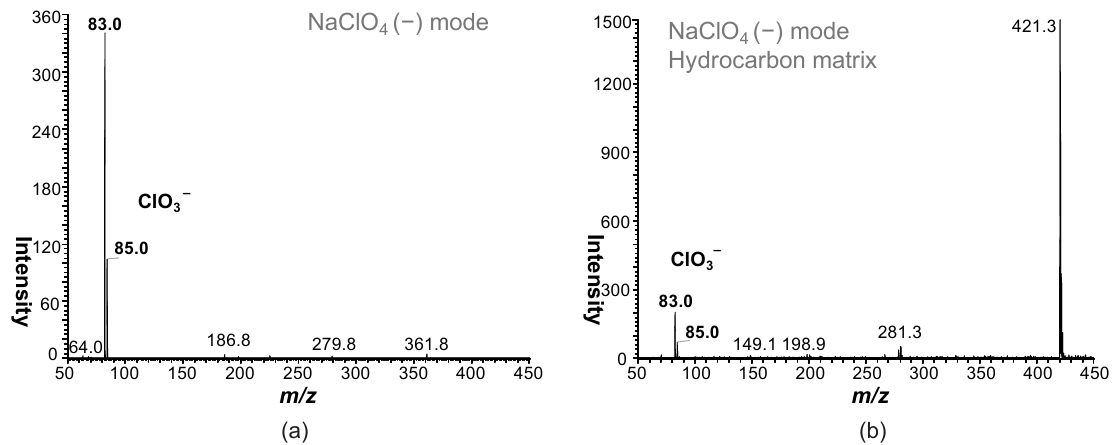
Table 3. Summary of matrix effects Analyte Surface